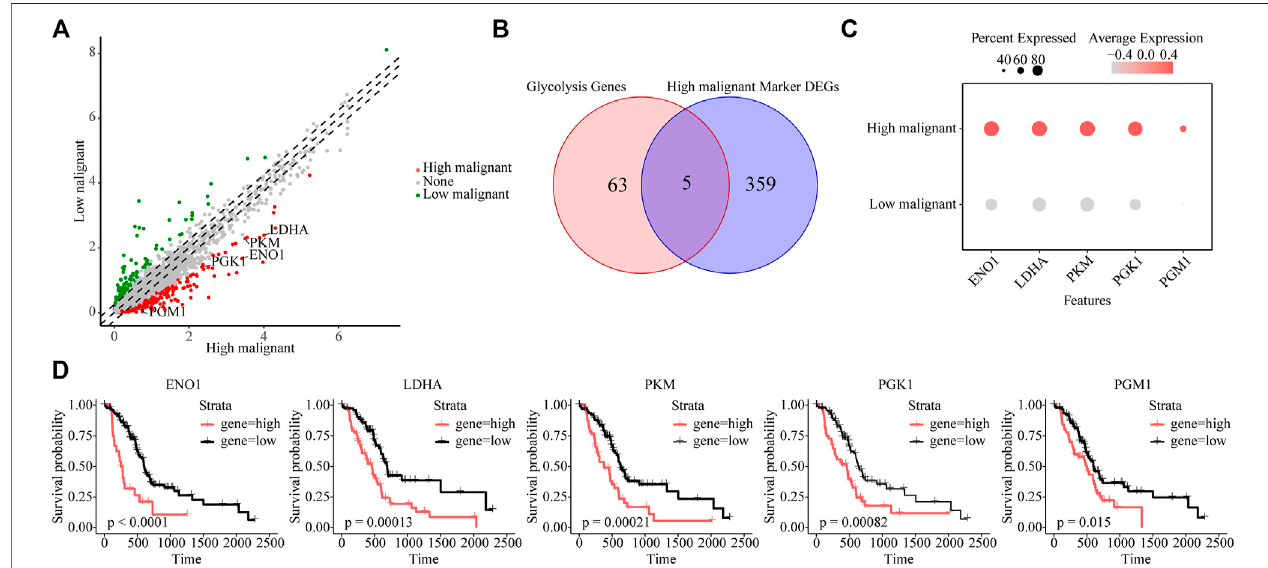
FIGURE 3 | Identifying glycolytic marker genes in highly malignant cell subpopulations. (A) Scatter plot of differentially expressed genes. Green, lowly malignant marker gene; red, highly malignant marker gene. (B) Venn diagram showing fi ve marker glycolytic genes among the highly malignant cell marker genes. (C) Dot plot to show the expression differences of fi ve glycolytic marker genes ranked from highest to lowest. (D) The association of fi ve marker glycolytic genes with survival based on TCGA data analysis.